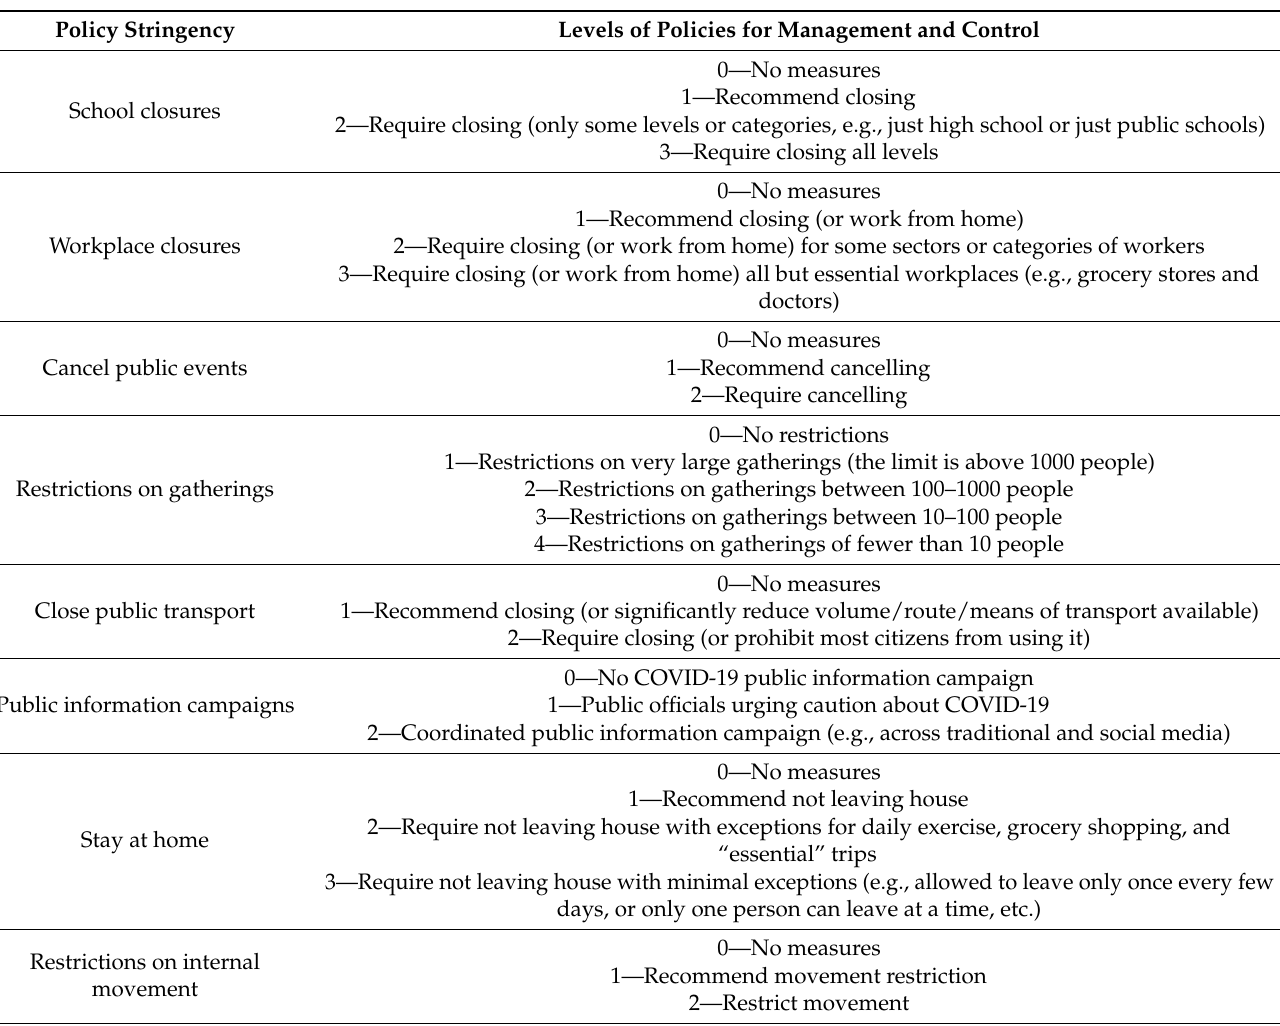
Table 2. Calculation methodology and score coding of government response stringency